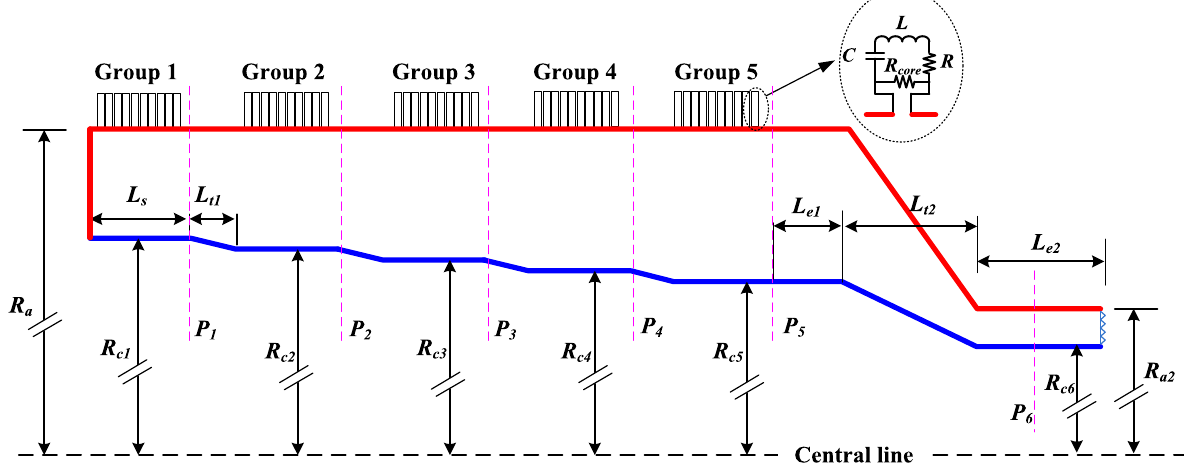
FIG. 3. Schematic of the model in PIC simulation. The external circuit boundary was used to drive the IVA. A conical section connects IVA to a coax in a smaller diameter. A matched output boundary was used at the end of the coax to avoid reflection. The lengths of final conical transition ( L ) and the final coax ( L ), and the load impedance were changed in different runs to achieve the different status of t 2 e 2 MITL operation.